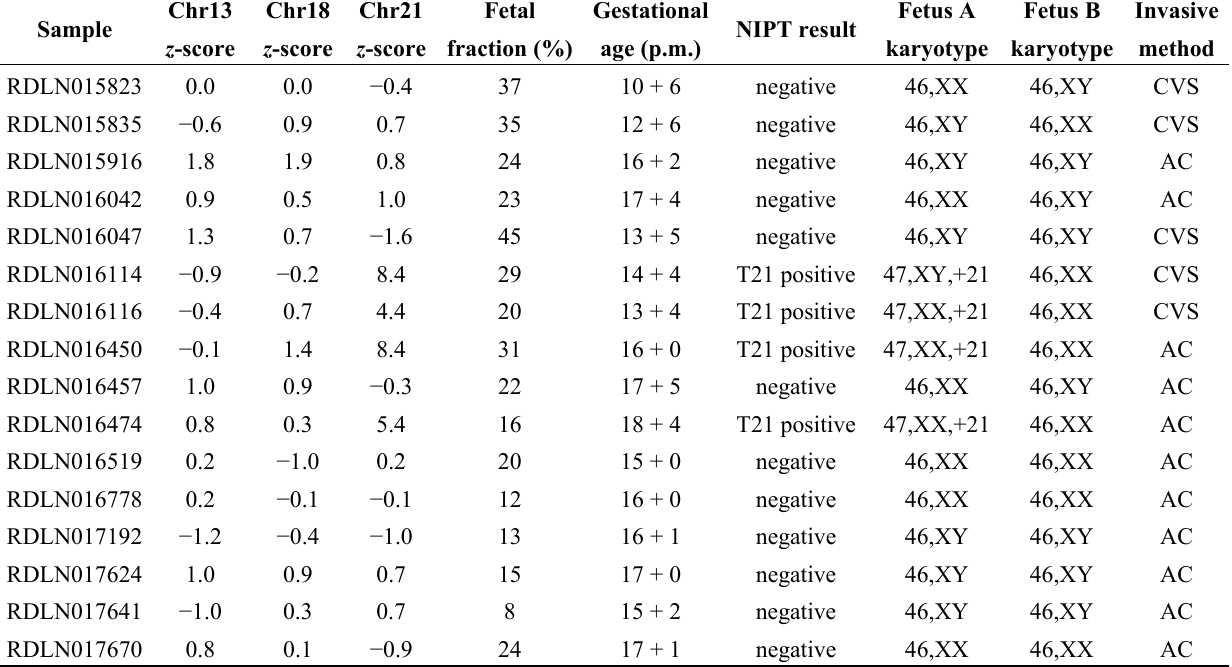
Table 1. Characteristics and NIPT results for the stored DNA